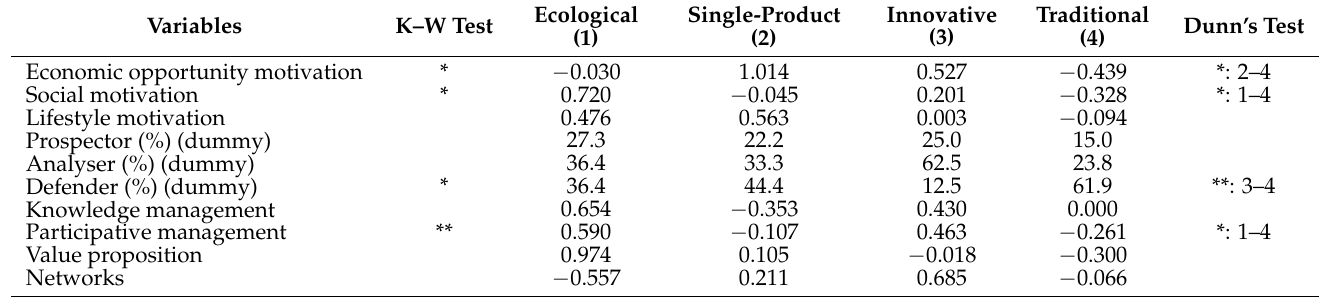
Table 6. Motivations and other entrepreneurial characteristics of the value-creating